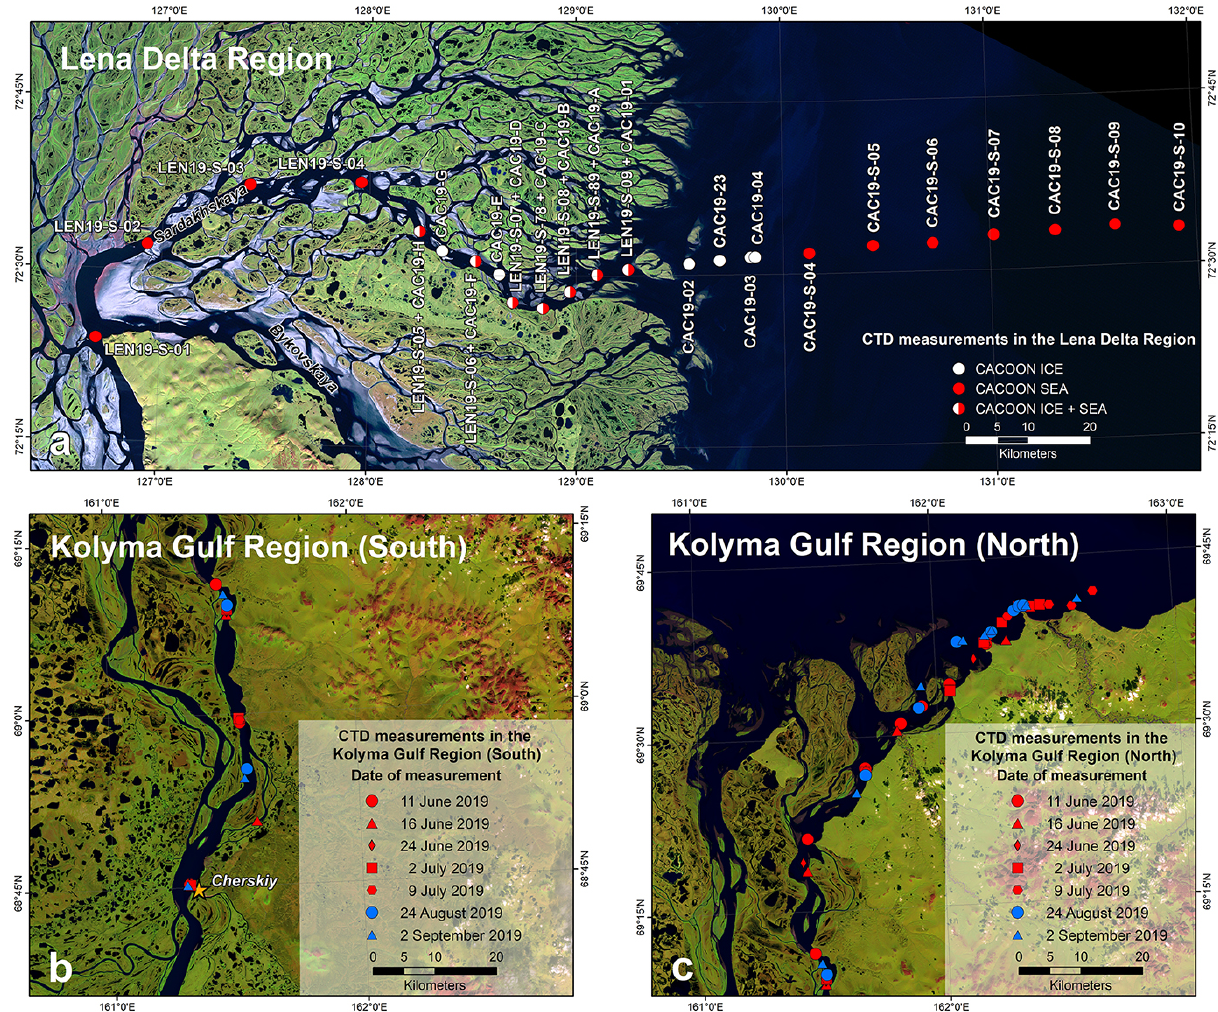
Figure 2. (a) CTD measurement locations in the Lena Delta region during the CACOON 2019 expeditions (Fuchs et al., 2021c, 2021d; Strauss et al., 2021, Appendix Table C1) starting from Stolb Island (LEN19-S-01), passing through the Sardakhskaya main channel to 80km offshore at CAC19-S-10 (background image: Landsat 5 mosaic (band combination 5, 4, 3) including scenes from 2009 and 2010; Landsat 5 image courtesy of the US Geological Survey). CTD data on the CACOON ice expeditions were collected from 30 March to 4 April 2019, and CTD data on the CACOON sea expedition were collected from 3 to 9 August 2019. (b) CTD measurement locations in the Kolyma Gulf region in the southern (b) and in the northern part (c) (Palmtag and Mann, 2021) (background image: Landsat 8 mosaic (band combination 6, 5, 3) including scenes from 2019; Landsat 8 image courtesy of the US Geological Survey). The orange star shows the city of Cherskiy. Campaigns in both regions aimed to cover the coastal near-shore and the transition zone from riverine to marine